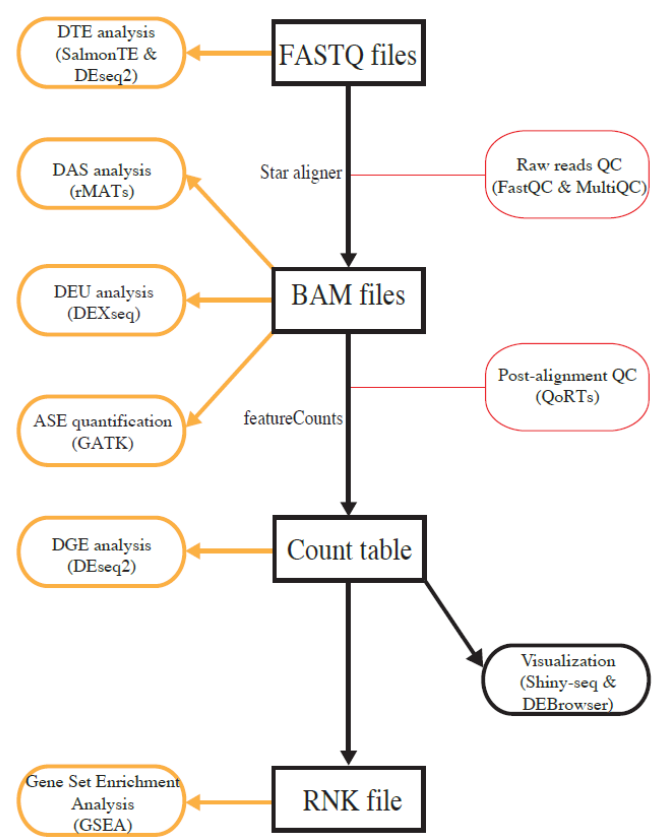
Figure 1. Overview of analysis workflows implemented in OneStopRNAseq. Software packages for each analysis task are shown in brown round-cornered rectangles enclosed by round brackets and along vertical black arrows.